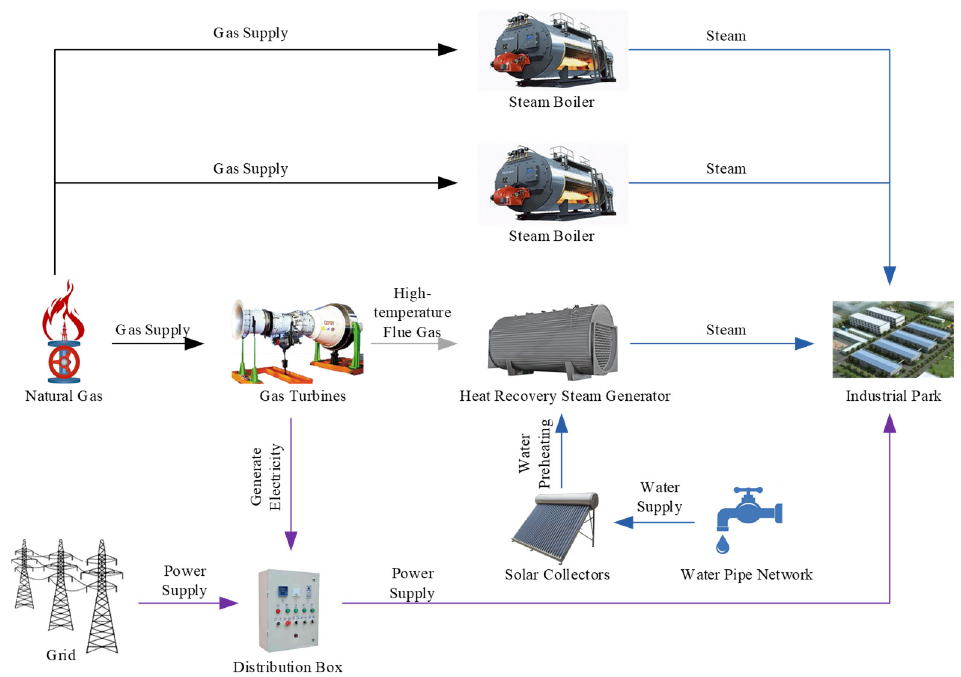
Figure 1. The structure and operational process of the CHP system.